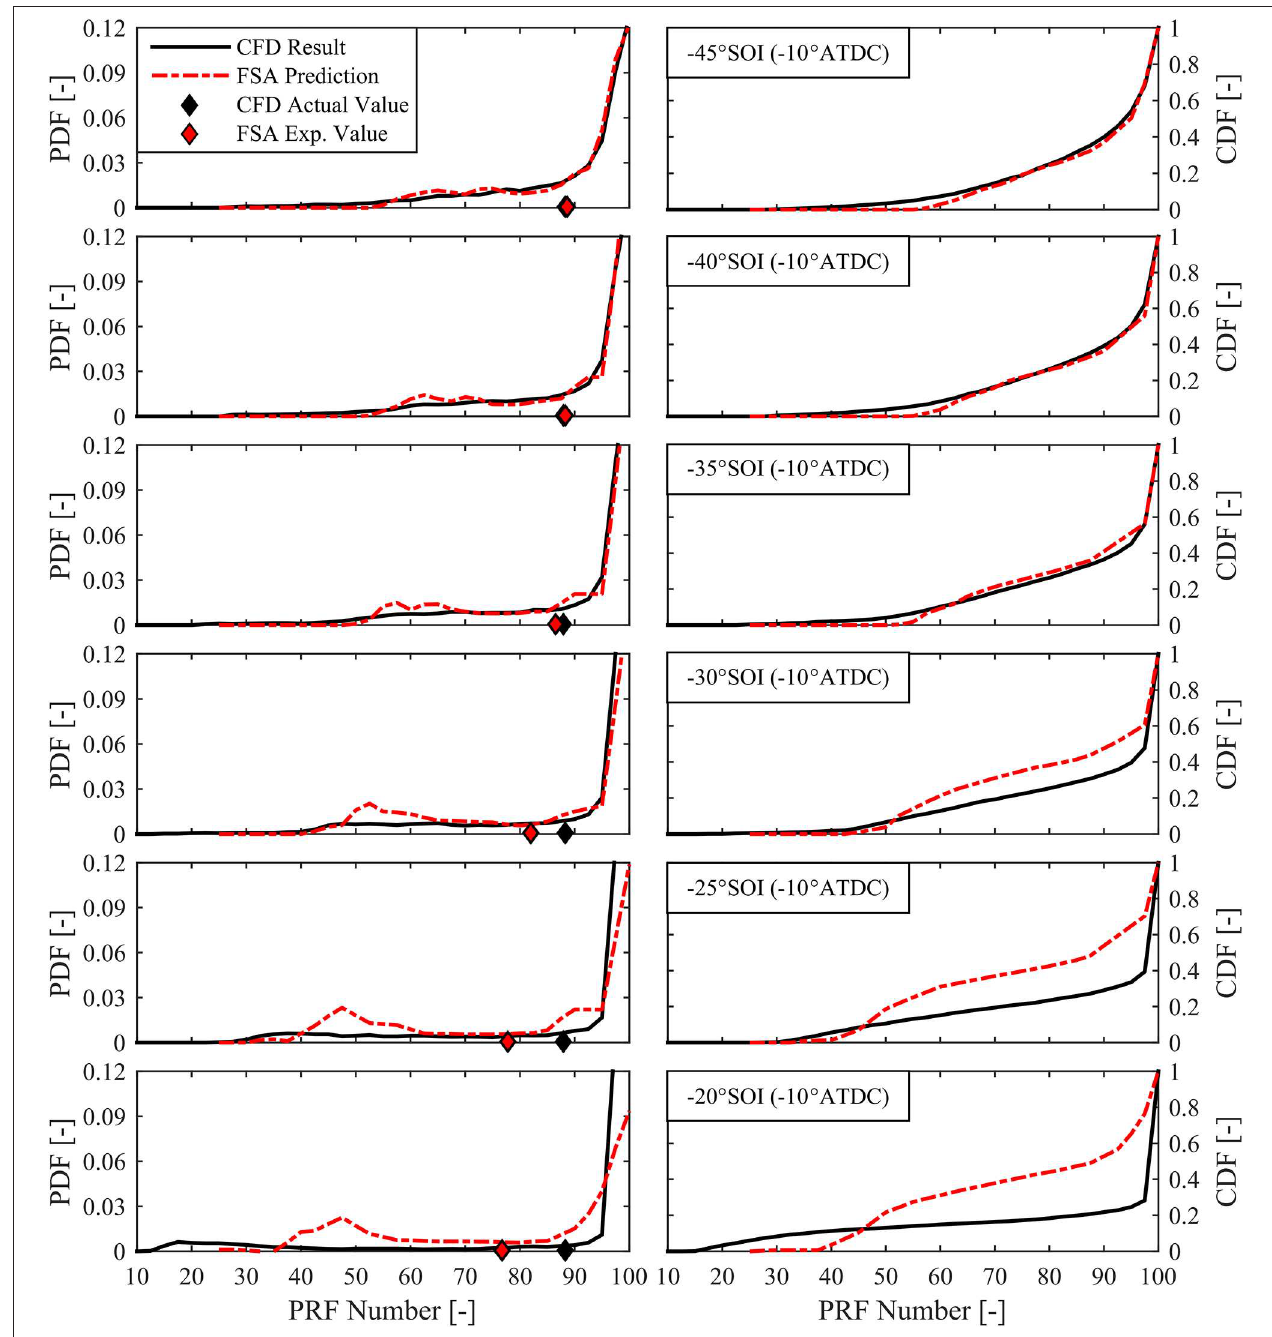
FIGURE 11 | PDFs (Left) and CDFs (Right) vs. PRF Number for non-reacting CFD at specified crank angle for specified SOI case from − 45 ◦ to − 20 ◦ , compared to normalized FSA method predicted